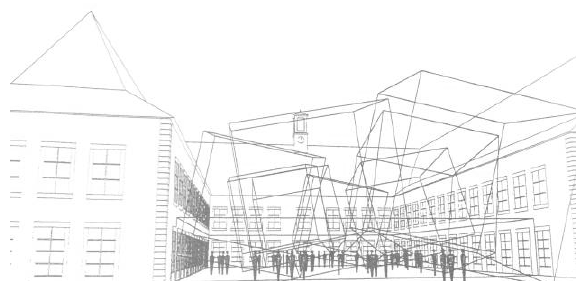
Figure 1: Design proposal for the European Business School in Wiesbaden by structural designer Mick Eekhout and sculptor Marijke de Goey as a composition of tumbling cubes.